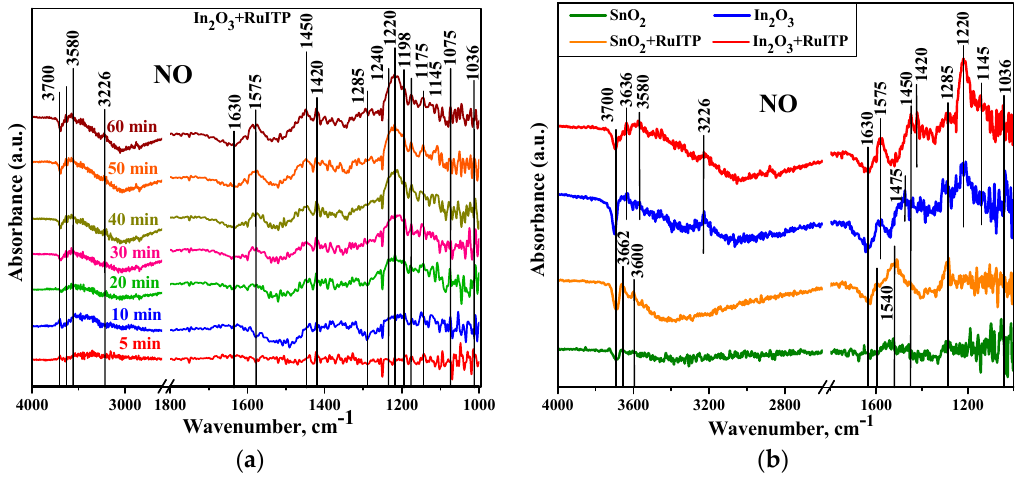
Figure 12. ( a ) In situ di ff use reflectance infrared Fourier transform spectroscopy (DRIFT) spectra of the In 2 O 3 + RuITP sample during NO (50 ppm) exposure at room temperature. ( b ) In situ DRIFT spectra of nanocrystalline SnO 2 and In 2 O 3 and hybrid materials after 60 min NO (50 ppm) exposure at room